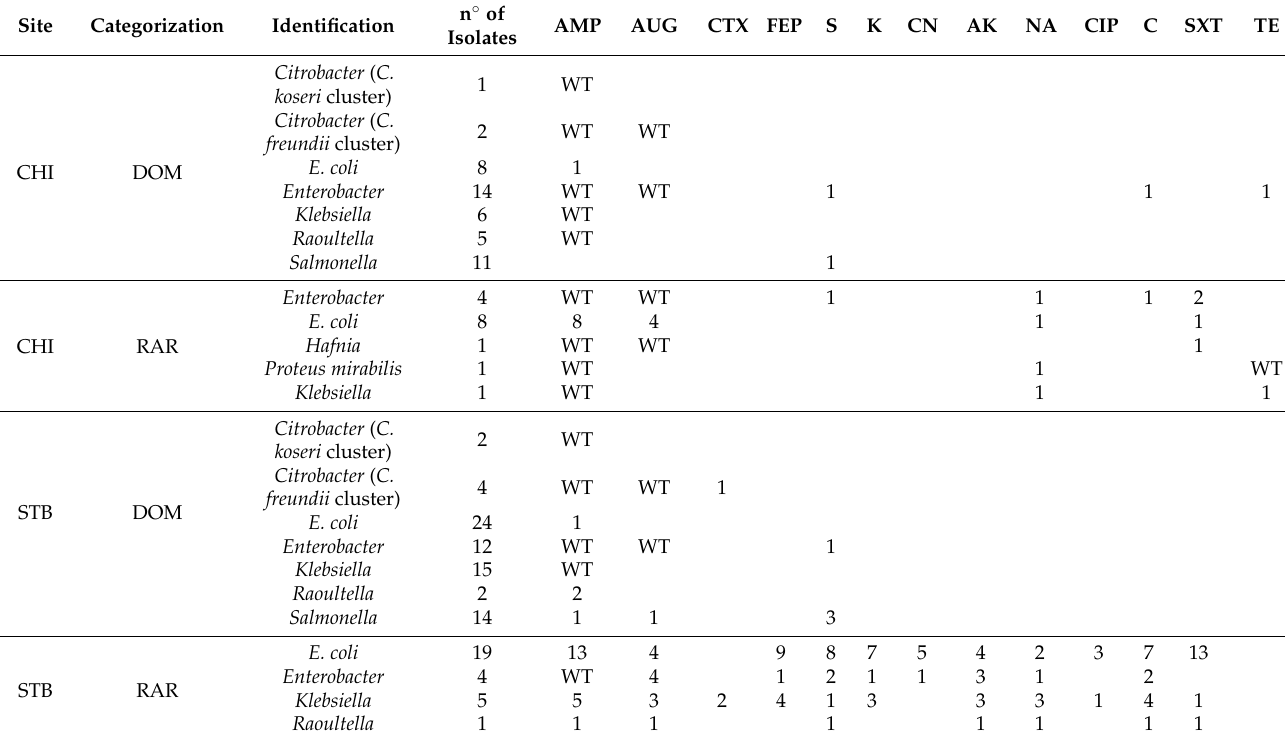
Table 1. Antibiotic susceptibility of dominant (DOM) and rare (RAR) enterobacterial isolates obtained from Iguana delicatissima cloacal